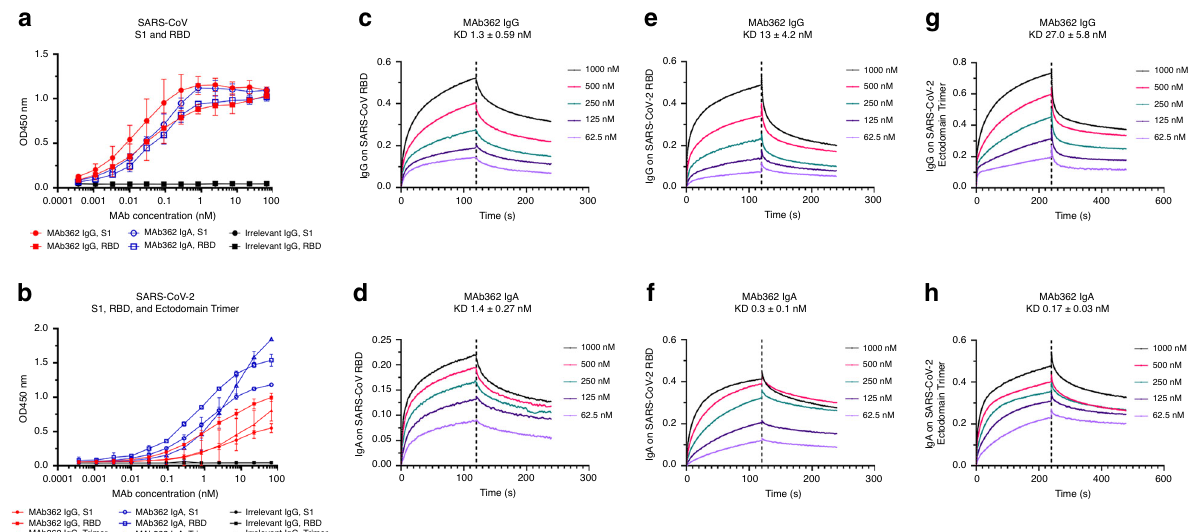
Fig. 1 Binding of MAb362 IgG and IgA to spikes of SARS-CoV and SARS-CoV-2. MAb362 IgG and IgA bind to puri fi ed SARS-CoV S1 (S 1 – 590 ) and RBD (S 270 – 510 ) truncations a and SARS-CoV-2 S1 (S 1 – 604 ), RBD (S 319 – 541 ), and ectodomain trimer b . IgGs are red lines, IgAs are blue lines, and irrelevant IgGs are black. Af fi nity measurements of MAb362 IgG c , e , g and IgA d , f , h against the RBD truncations of S glycoprotein of SARS-CoV and SARS-CoV-2 c – f , as well as ectodomain trimer of SARS-CoV-2 g , h were conducted using bio-layer interferometry and demonstrate nano and sub-nanomolar af fi nities. Data are plotted as the mean ± s.d. from n = 3 independent experiments a , b . Source data are provided as a Source Data fi and SARS-CoV-2. This fi nding was consistent with the strong activity of MAb362 of compromising RBD – receptor interaction. epitope can only be exposed if the RBD was in the open or up this epitope would not be accessible to MAb362 without major steric clashes. However, unlike CR3022 for instance, MAb362 could access the ACE2-binding epitope(s) if one or more of the trimers is in this open conformation, potentially accounting for the added neutralizing activity.